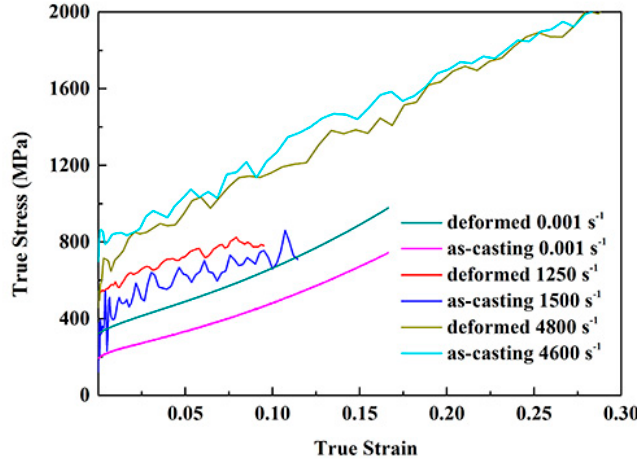
Figure 6. Compressive true stress–strain curves of NiCrFeCoMn HEA under different status at different strain rates.